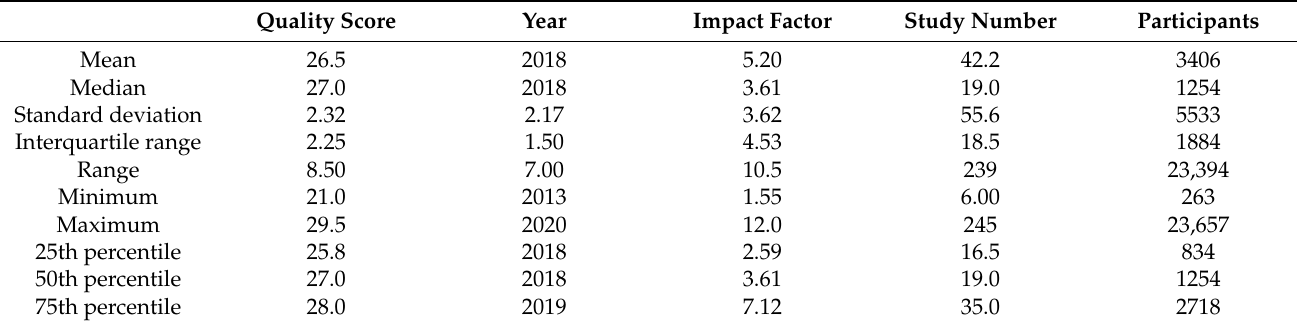
Table 5. Descriptive statistics of the NMAs included in this evaluation.